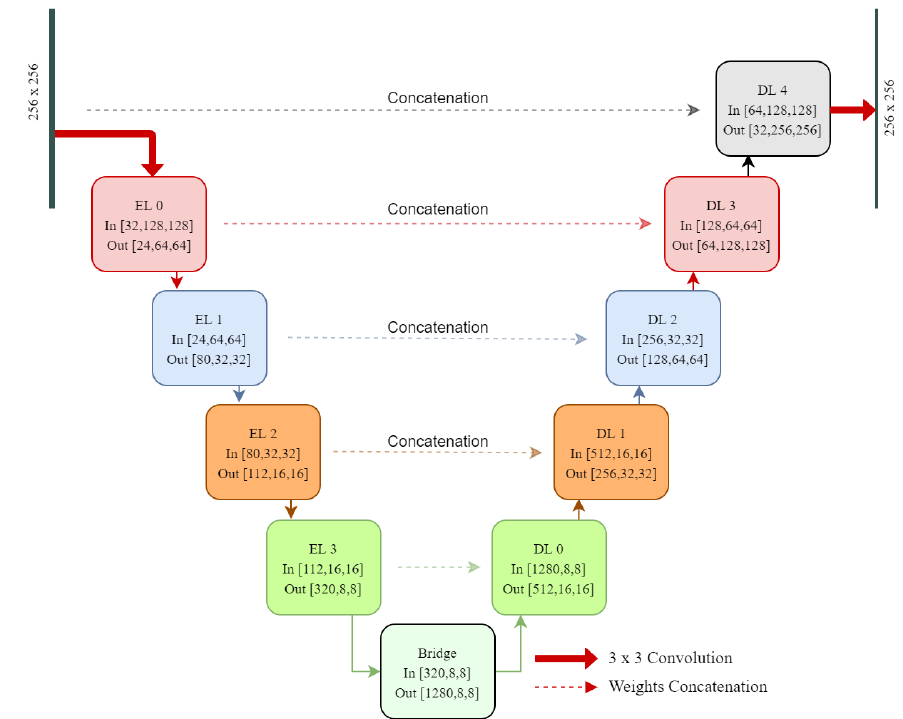
Figure 5. EfficientNet U-Net architecture used for training and testing. The input is a 4-band PlanetScope image. The output is a 2-band image containing the probability of each class for each pixel. The encoder part of the networks is an EfficientNet B0 network, while decoder units contain two 3 × 3 convolutions. The first convolution layer of the EfficientNet was modified to input 4-band imagery. Due to the large number of layers in the EfficientNet model, a simplified block diagram is shown